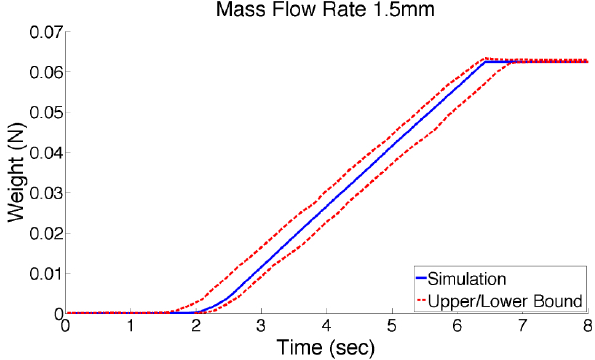
Figure 14. Weight vs. time for a gap size of 1.5mm. This was the test case that was used for calibration.